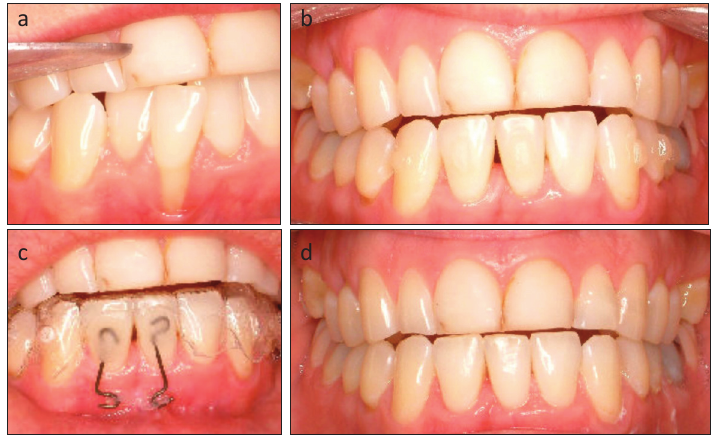
Figure 1. The use of auxiliaries to improve root parallelism. (a) The 41 to be extracted owing to labio-gingival dehiscence and patient choice for lower arch treatment only. (b) Result after 23 aligners. (c) Auxiliary power arms and chain elastic in place. (d) Result after six weeks.